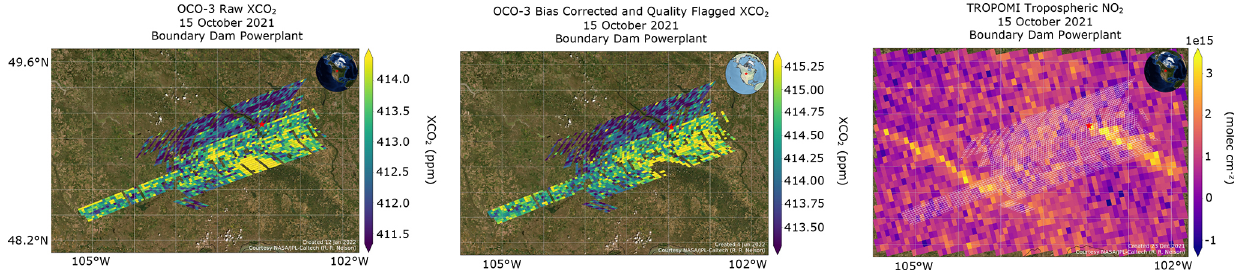
Figure 23. A v10 OCO-3 SAM at Boundary Dam power plant in Saskatchewan, Canada, which appears to have a true swath bias, even after bias correction and quality filtering. The SAM was taken at 16:42UTC (10:42LT), and MODIS data indicate high AODs of around 0.3 in the area on this